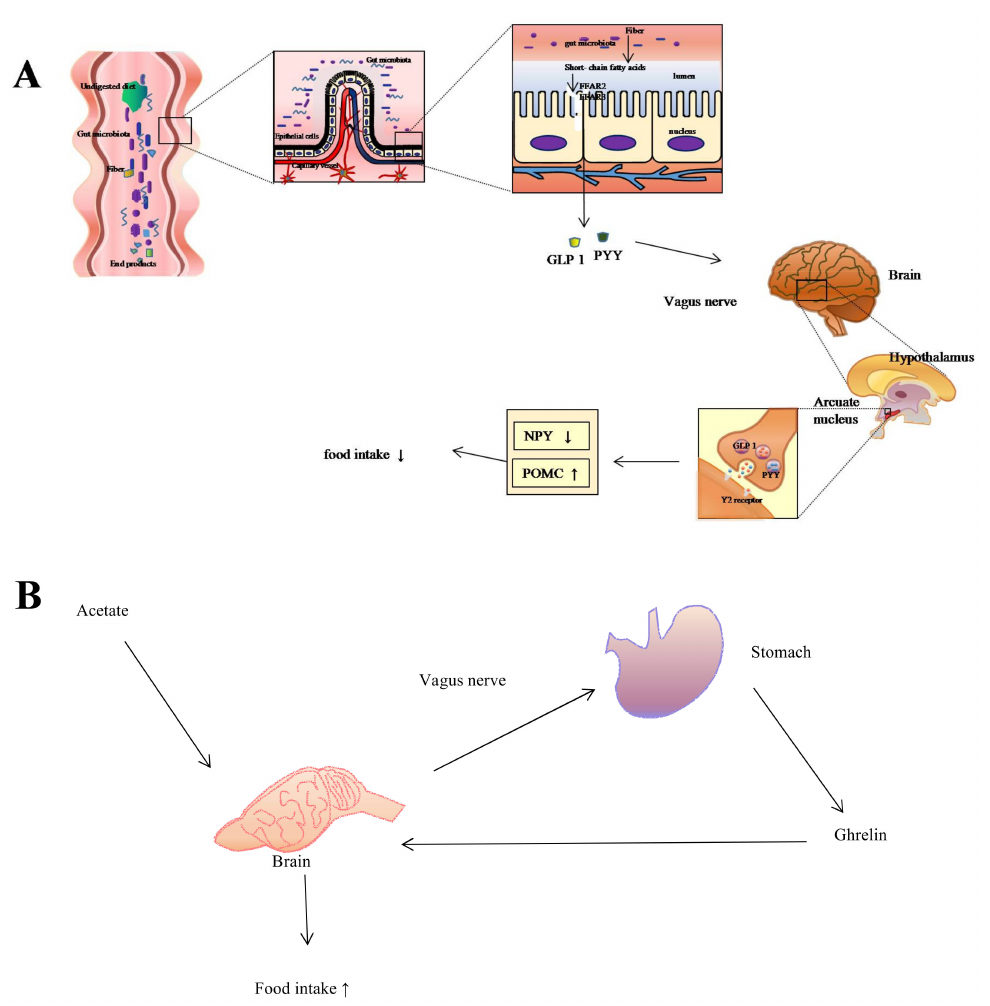
Figure 1. Regulation of food intake via gut-brain pathway. ( A ) When undigested dietary residue arrives at the caecum, colon, rumen, and hind gut, the bacteria populated in the intestines ferment them to short-chain fatty acids (SCFAs) (e.g., acetate, propionate, and butyrate). Then free fatty acid receptor 2 (FFAR2) and free fatty acid receptor 3 (FFAR3) on the L-cells interact with SCFAs to trigger the secretion of anorectic hormones, including peptide YY (PYY) and glucagon-like peptide 1 (GLP1). PYY and GLP1 then preferentially bind to the Y2 receptor located on the arcuate nucleus of the hypothalamus via the vagus nerve, which further increases the expression of the anorexigenic pro-opiomelanocortin (POMC) neuropeptide while decreasing the expression of neuropeptide Y (NPY), thus managing to control food intake; ( B ) Microbiota ferment dietary nutrients, digesting them to SCFAs. Acetate molecules then stimulate the vagus nerve, which triggers the stomach to secrete the “hunger hormone” ghrelin, leading to the increase of food